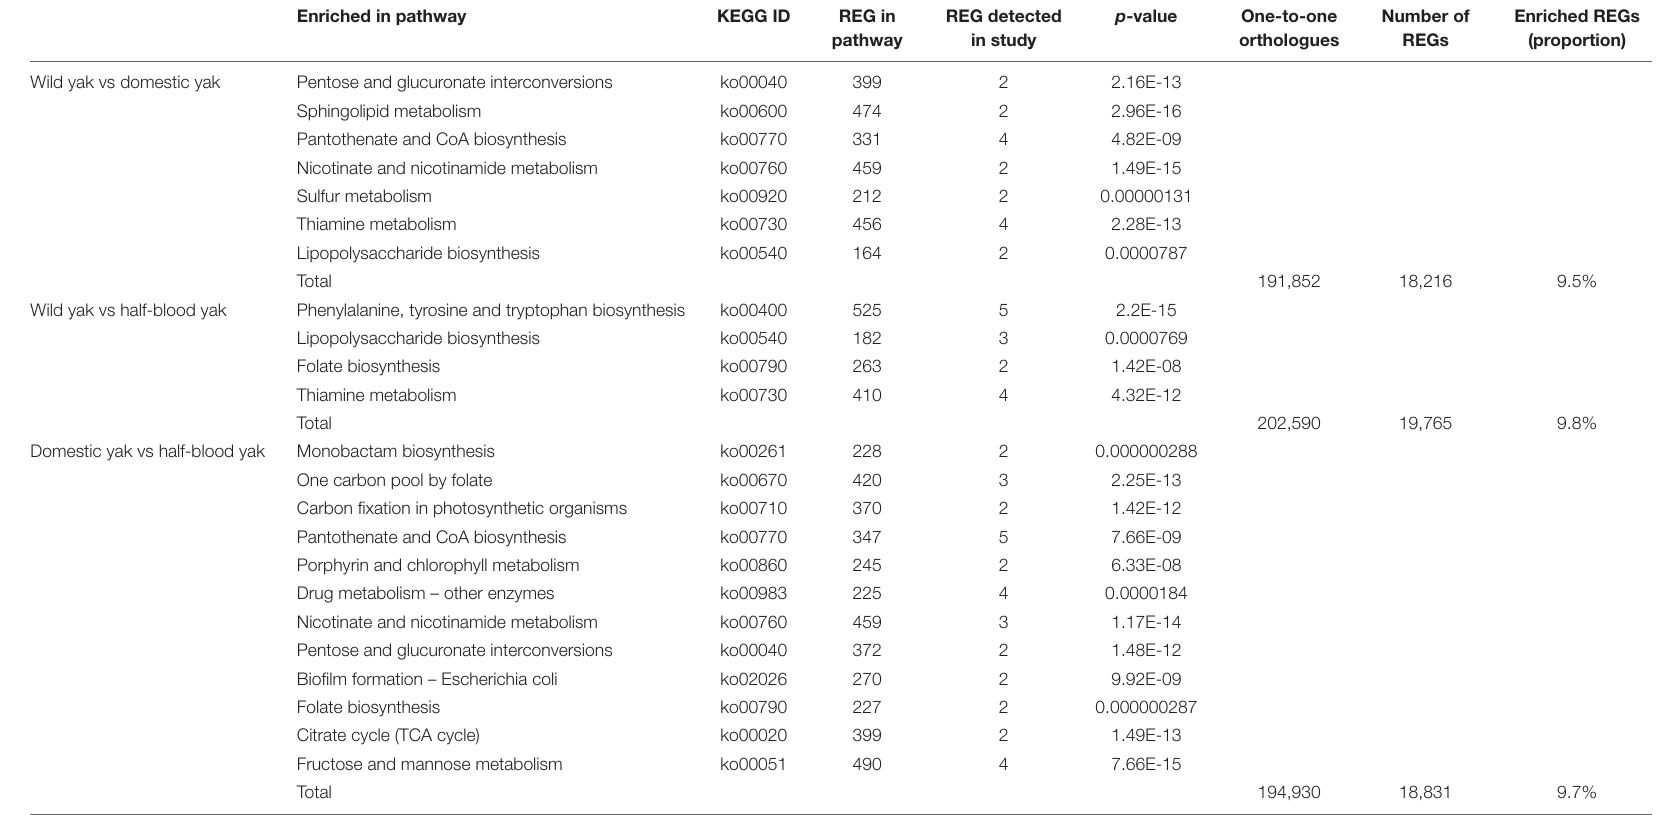
TABLE 2 | Functional categories with significant enrichment in rapidly evolved genes